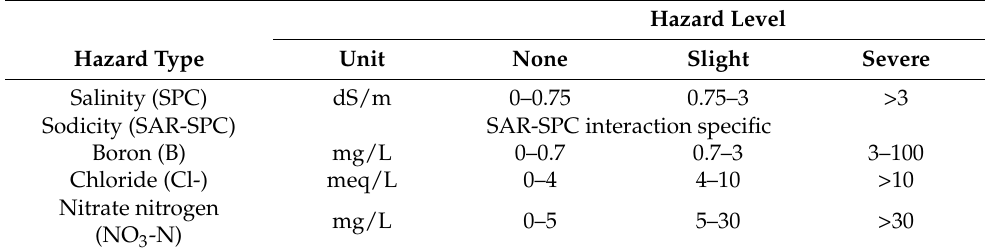
Table 9. Hazard class ranges for determination of level of hazard